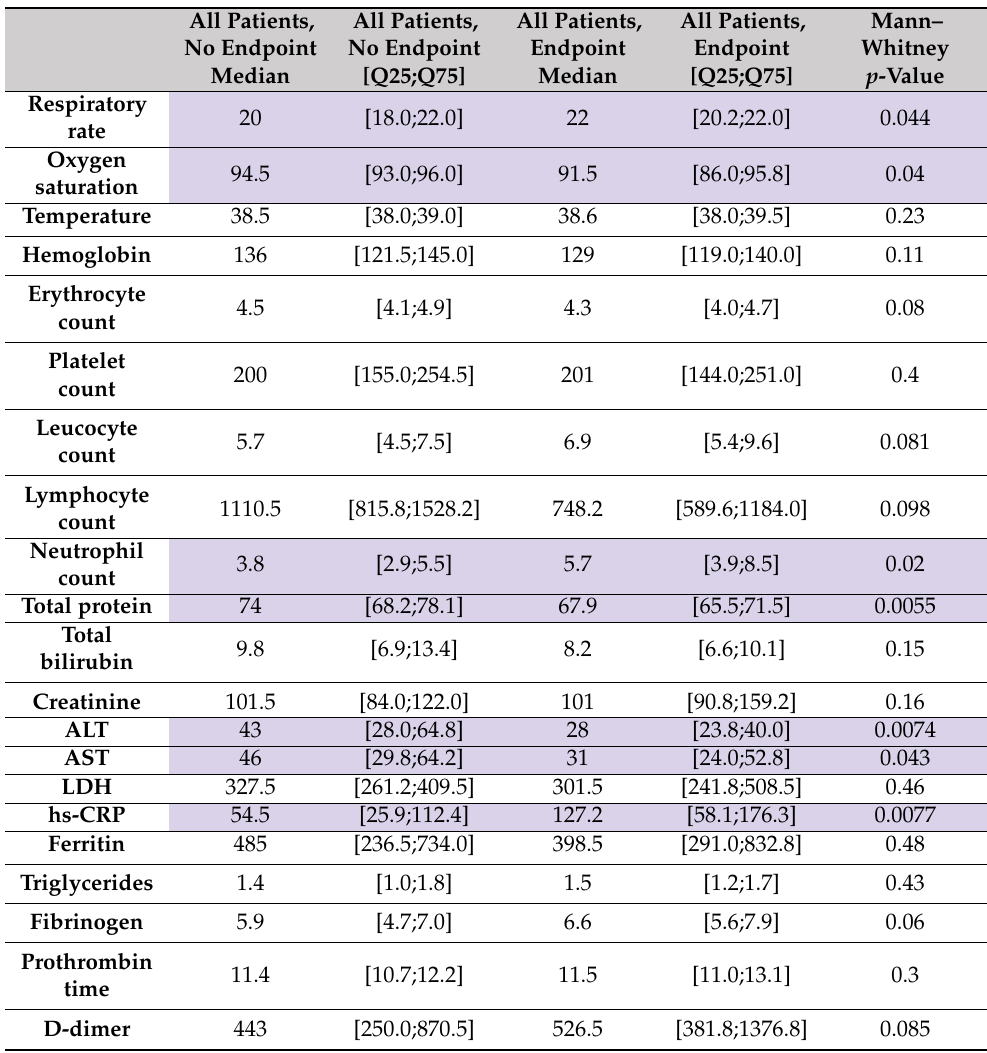
Table 6. Comparison of laboratory and clinical parameters at timepoint 1 between patients with and without combined endpoint in all patients. Data are presented as median and interquartile range [Q25;Q75]. p -values are presented according to the Mann–Whitney